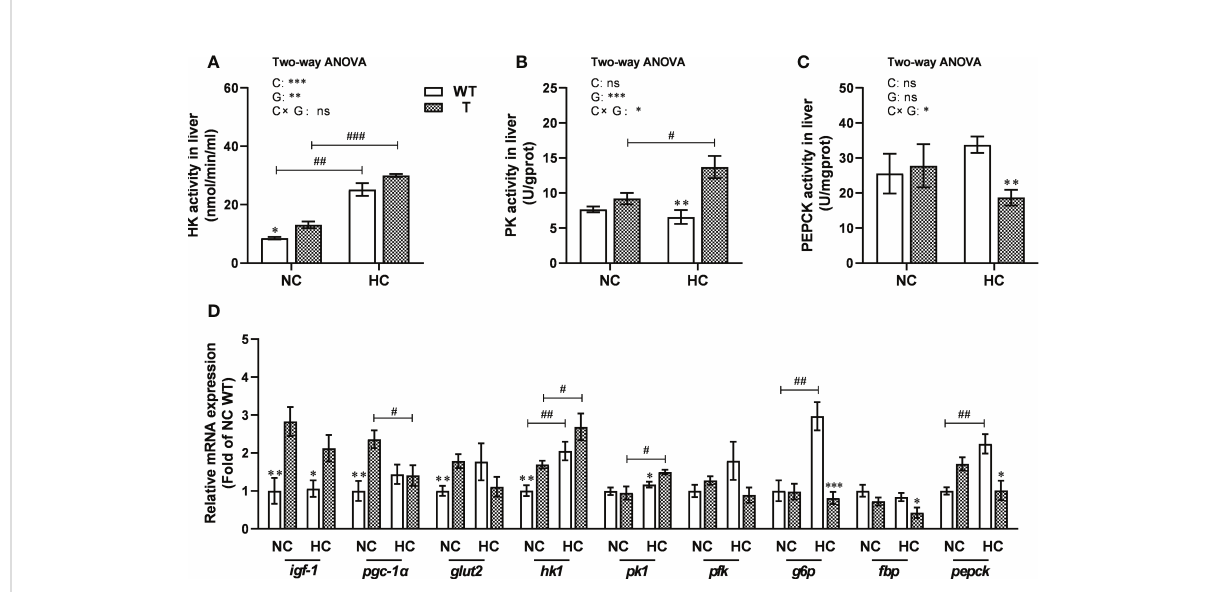
FIGURE 6 Hepatic enzymatic activity and expression levels of genes involved in carbohydrate metabolism in T and WT common carp fed a normal or high-carbohydrate diet. (A-C) Activity levels of hexokinase (HK), pyruvate kinase (PK), and phosphoenolpyruvate carboxylase kinase (PEPCK) in the liver. (D) The expression levels of genes involved in carbohydrate metabolism in the liver (n = 6). *, ** and *** indicate a signi fi cant difference ( P < 0.05, P < 0.01, and P < 0.001, respectively) in different strains at same dietary starch content. #, ## and ### indicate a signi fi cant difference ( P < 0.05, P < 0.01, and P < 0.001, respectively) in the same strain with different dietary starch contents. In two-way ANOVA, C, carbohydrate; G, GH. * P < 0.05, ** P < 0.01, *** P < 0.001; ns, indicates no signi fi